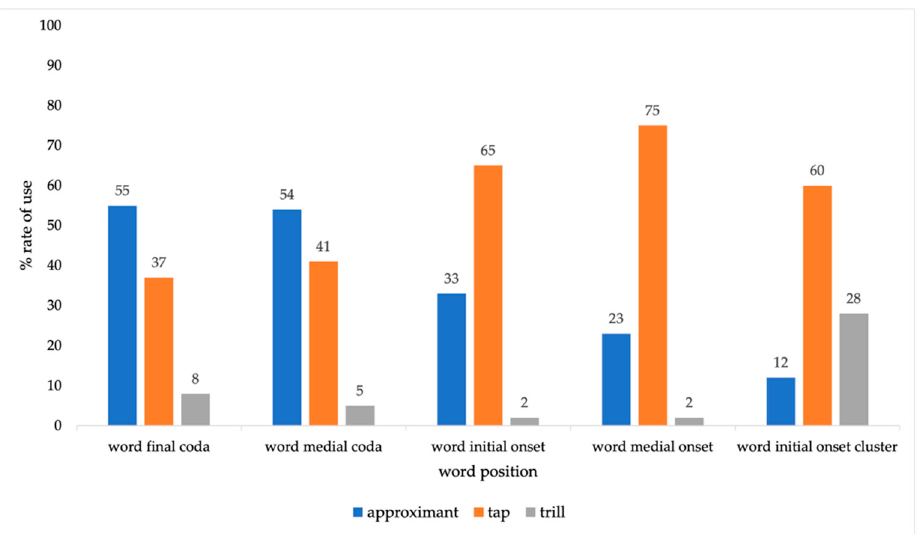
Figure 1. Frequency of the (r) variants by word position, n = 3351 (showing data from Rentillo and Nuñez 2011).